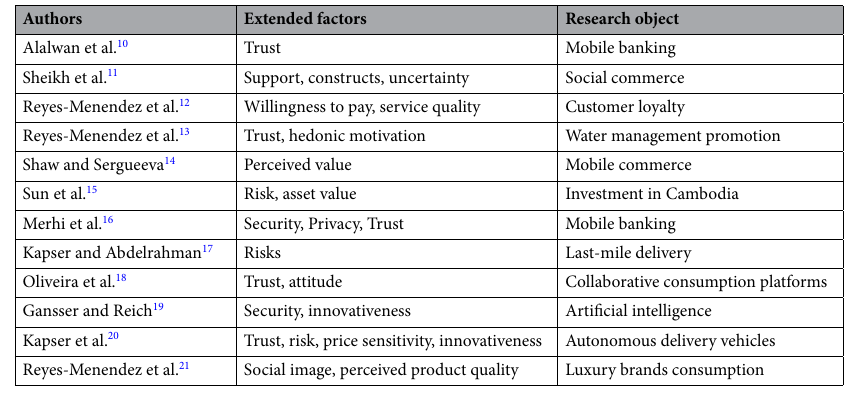
Table 1. Previous researches extending